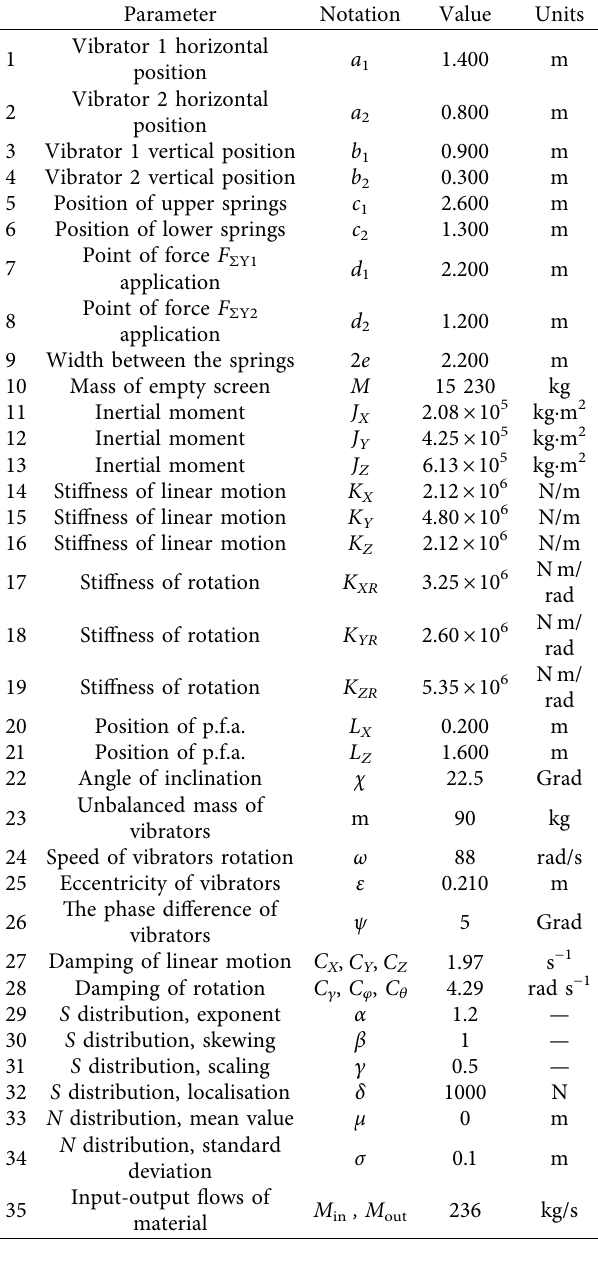
Table 1: The parameters taken in simulations of the dynamical